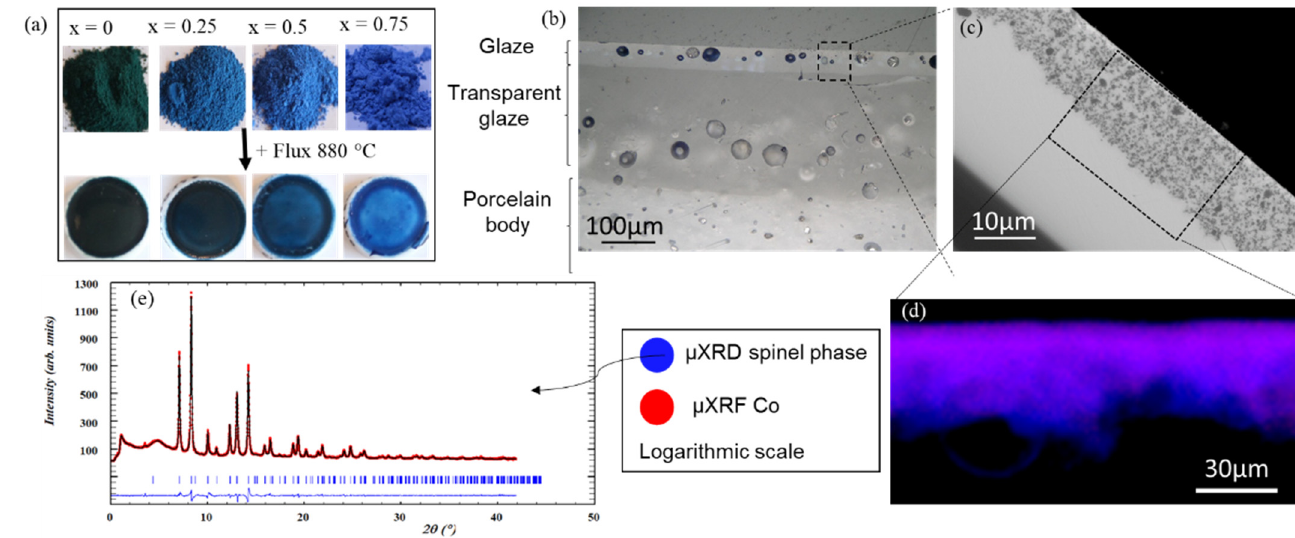
Figure 5. Study of the stability of Co 1-x Al 2+2x/3 O 4 spinel pigments in a porcelain glaze. ( a ) Pigments x = 0; 0.25; 0.5 and 0.75 fired at 1000 °C and their respective glazes; ( b ) Optical microscopy image of the cross-section of a painted porcelain; ( c ) SEM image of the glaze layer of glazed sample (x = 0.25 at 1000 °C); ( d ) µXRF and µXRPD map of glazed sample (x = 0.25 at 1000 °C) acquired on ID13, blue = µXRPD signal of the spinel phase, red = µXRF signal of Co (K-edge); the XRPD pattern of CoAl 2 O 4 in the glaze is then compared with the ( e ) HR-XRPD diagram of the pigment sample, (x = 0.25, at 1000 °C) acquired on ID22 (35 keV).